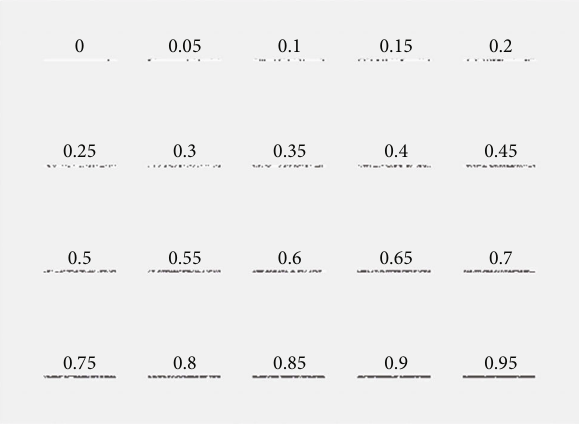
Figure 1: Initialization of roads under di ff erent occupancy.